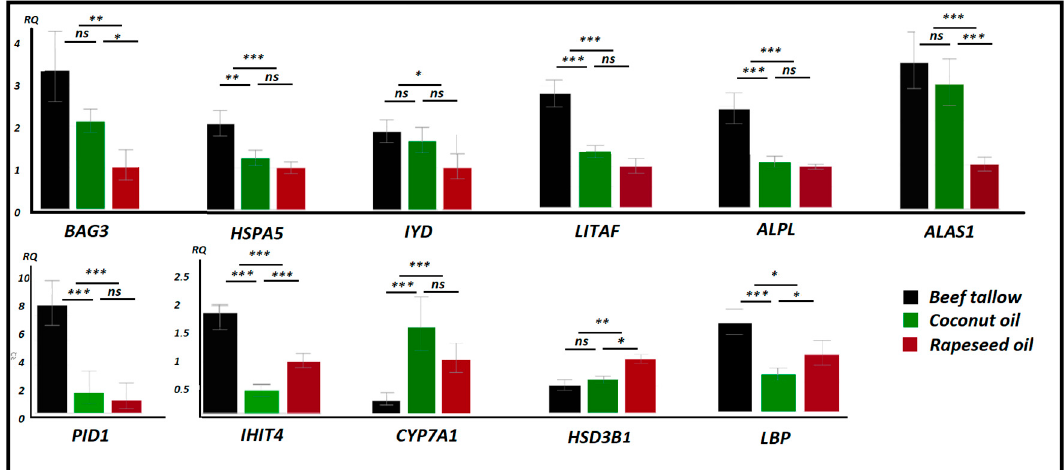
Figure 7. Results of the qPCR analysis of selected DEGs. RQ—Relative Quantity of mRNA, *** p < 0.01, ** p < 0.05, * p < 0.1, ns—not significant.